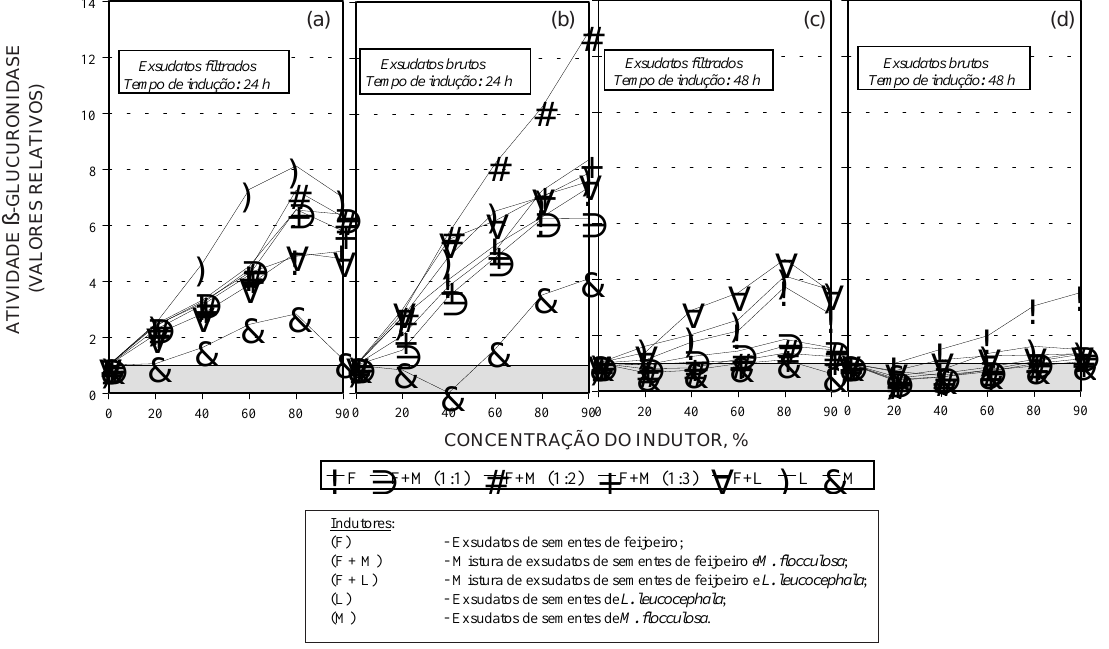
Figura 2. Atividade da enzima ß-glucuronidase, resultante da indução dos genes nod da estirpe F 98.5 (pGUS 32) pela presença de exsudatos de sementes filtrados (a, c) e brutos (b, d), em dois tempos de indução distintos (24 e 48 h). Valores relativos aos controles (culturas de bactérias na ausência de indutores - exsudatos de sementes). Os valores referentes aos controles são iguais a 1,0.